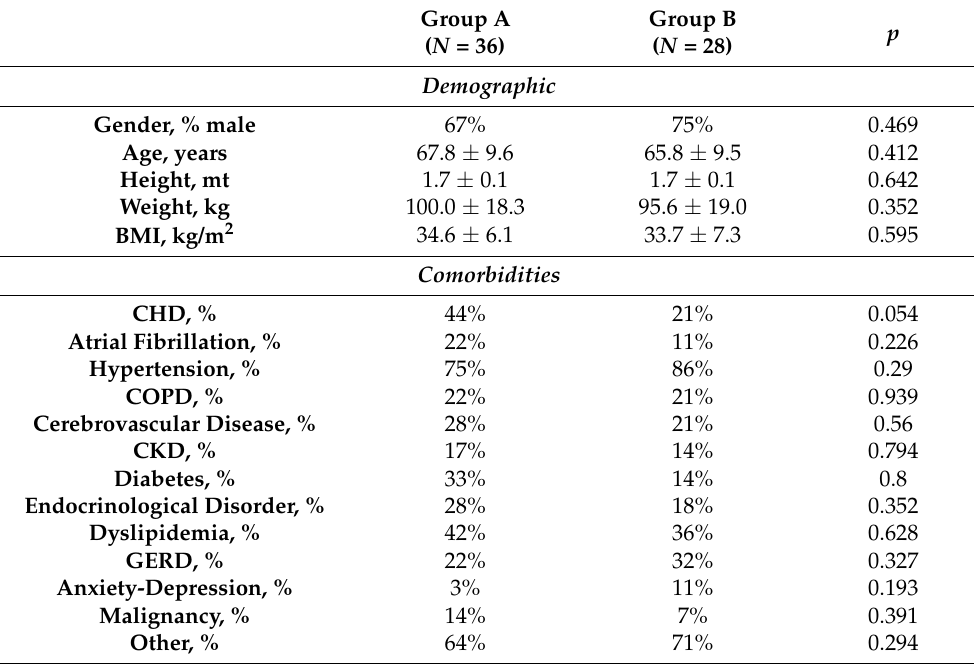
Table 2. Demographic and clinical characteristics of two groups